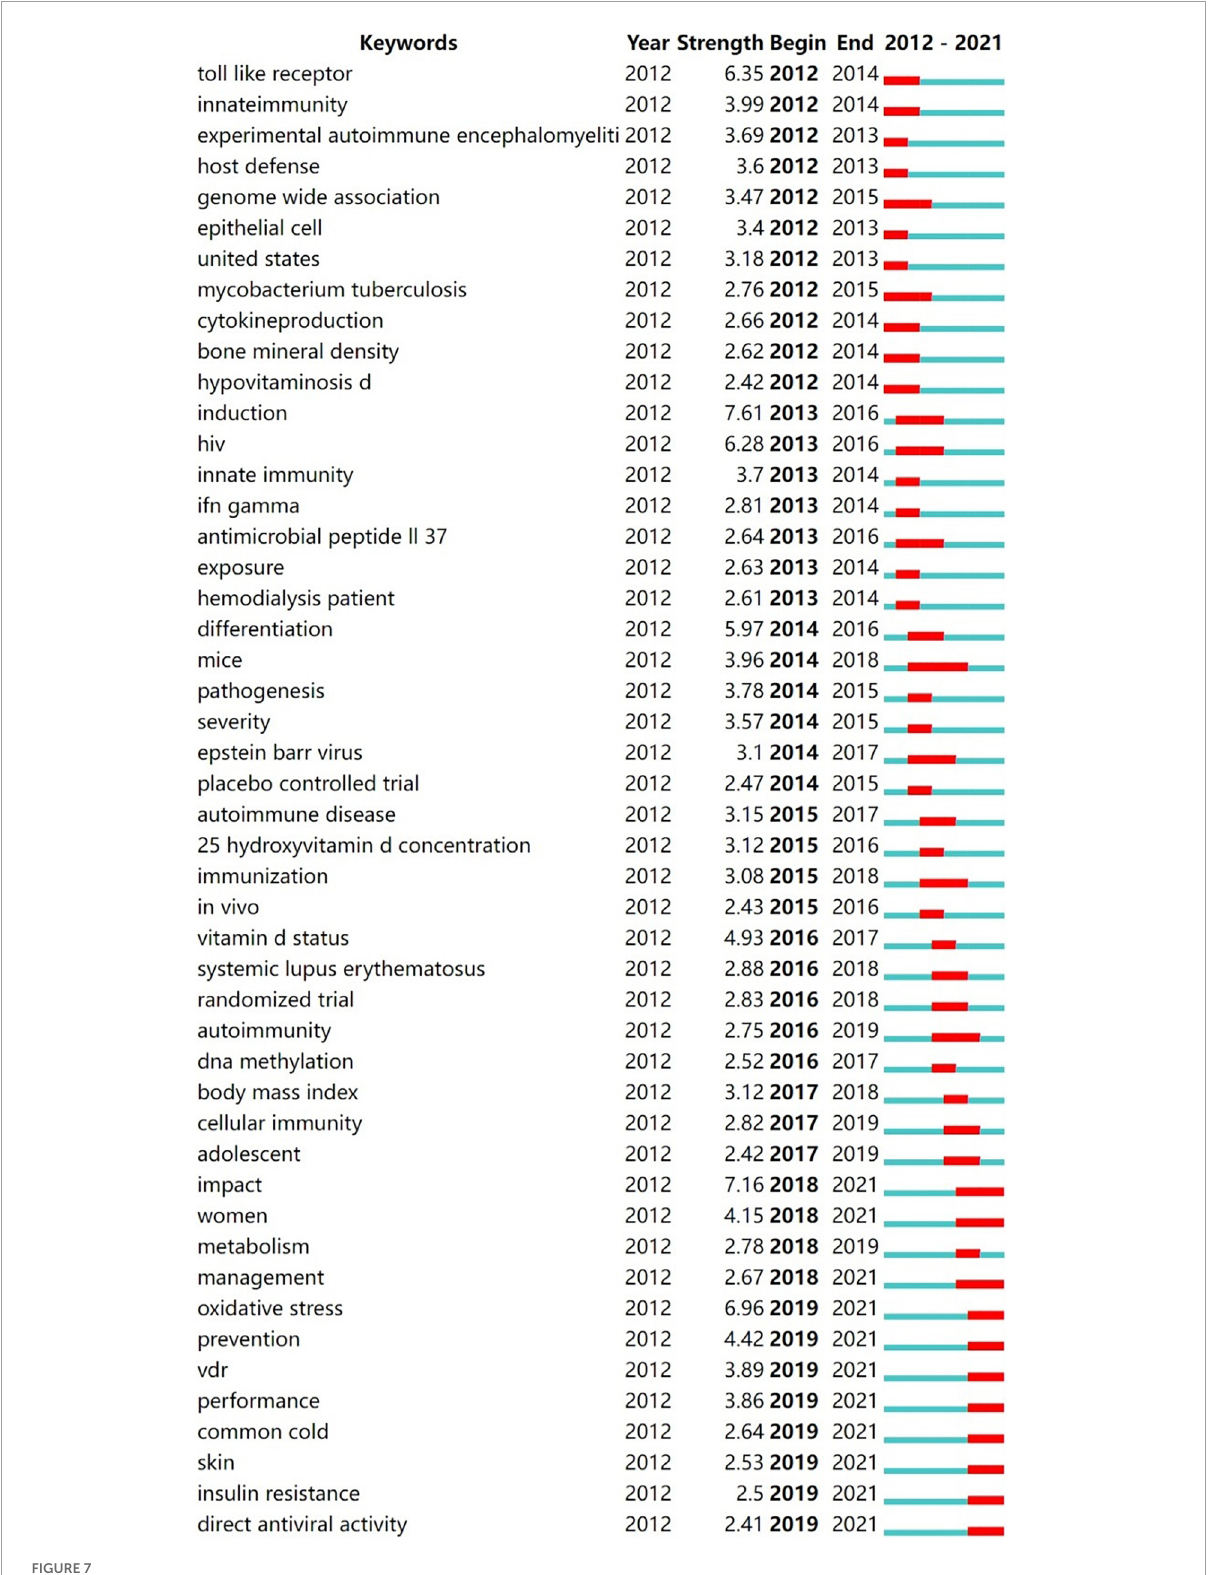
Frontiers in Nutrition